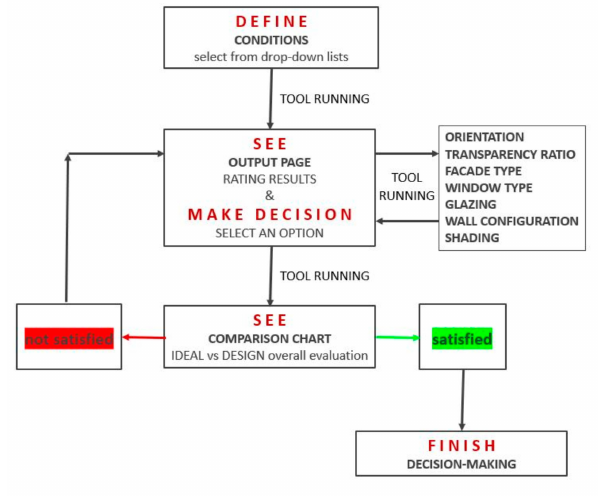
Figure 6. Flowchart for tool usage.